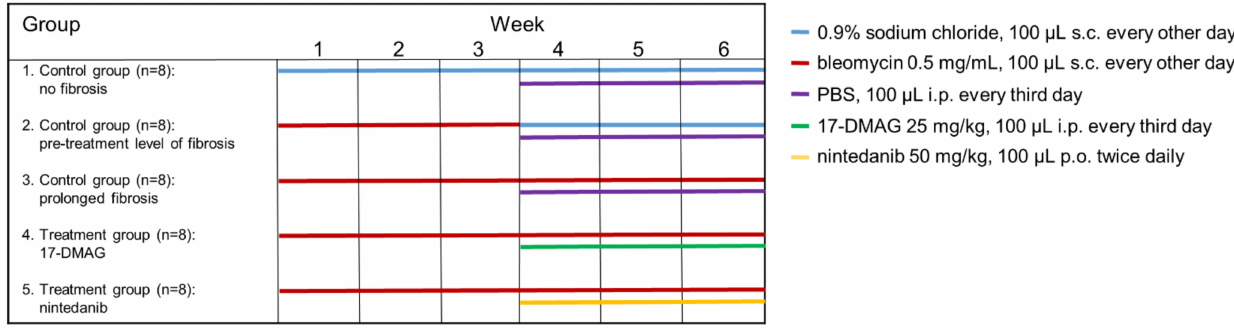
Figure 1. Design of the modified model of bleomycin-induced experimental dermal fibrosis. PBS, phosphate buffered saline; 17-DMAG, 17-dimethylaminoethylamino-17-demethoxy-geldanamycin (inhibitor of heat shock protein 90); s.c., subcutaneously administered; i.p., intraperitoneally administered; p.o., perorally